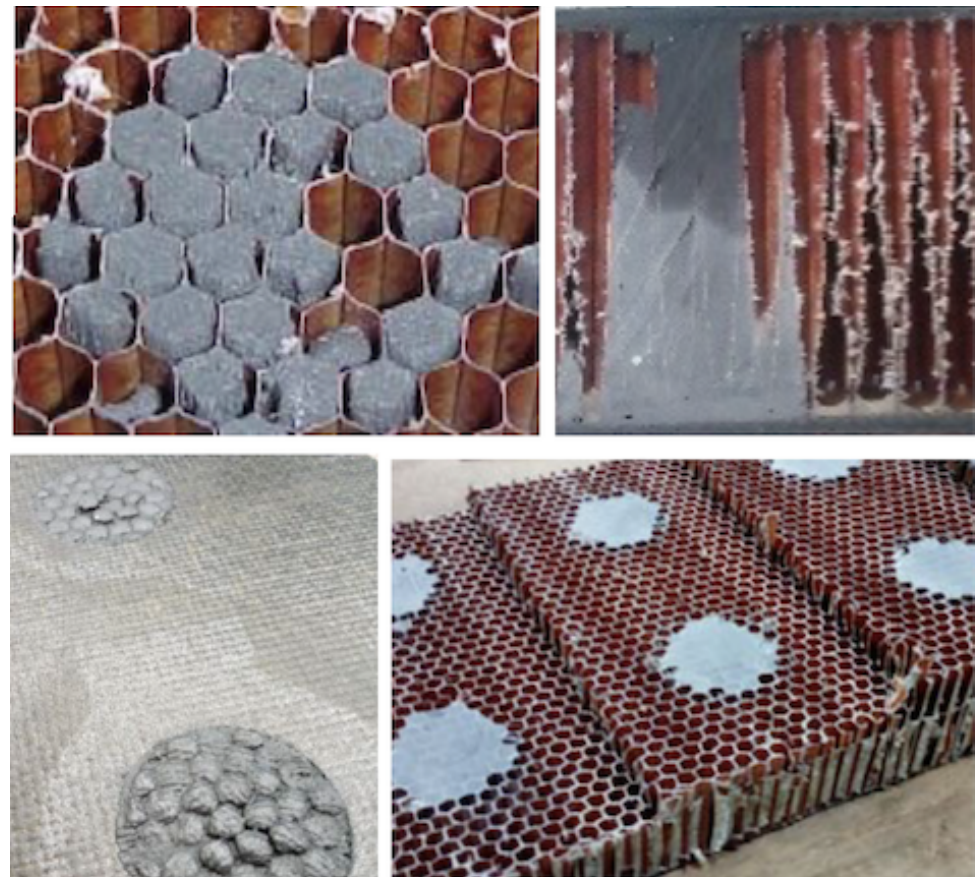
Figure 11. UPPER-LEFT : The potting results are faulty if one or more cells are empty in the central part, or if the cells are not completely filled. Both cases are clearly visible in this picture. UPPER- RIGHT : The cutting of the panel allows for the direct inspection of partially empty internal cells, as in the picture. LOWER-LEFT : The resin must overflow the cells to ensure their proper filling. LOWER-RIGHT : The potted spots are grounded to complete the